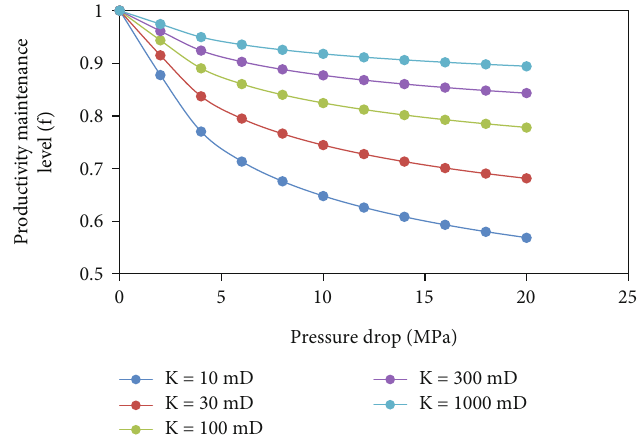
Figure 5: E ff ect of stress sensitivity on productivity decline (single-phase production).